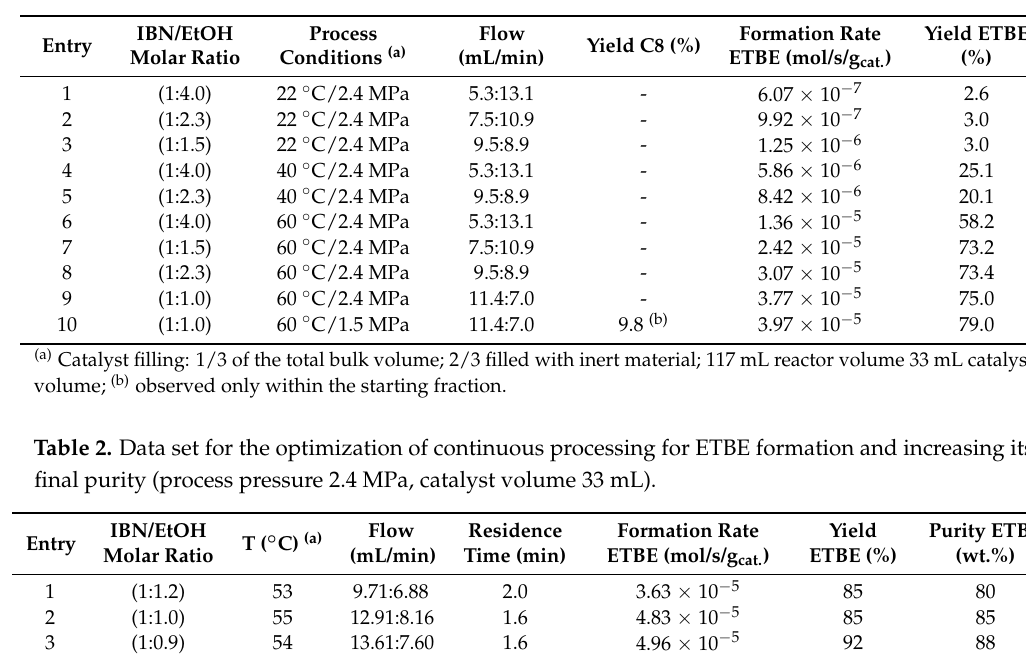
Table 1. Data set of the initial screening for continuous processing and ETBE formation using fossil-based isobutylene IBN (constant residence time τ = 1.8 min).